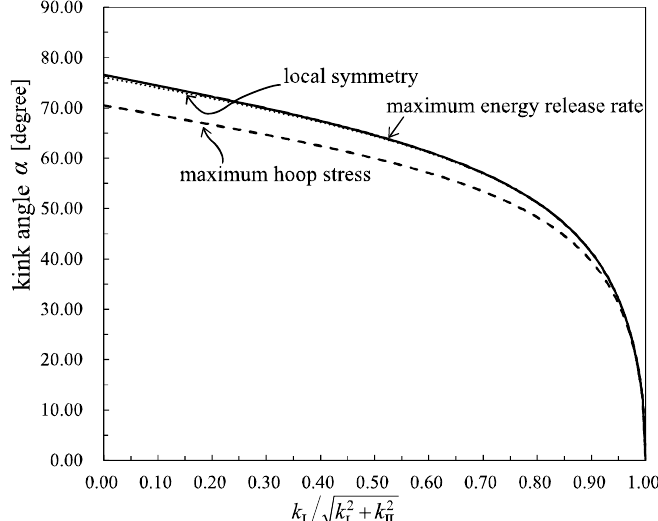
Figure 3: Comparison of the kink angles under mixed mode conditions